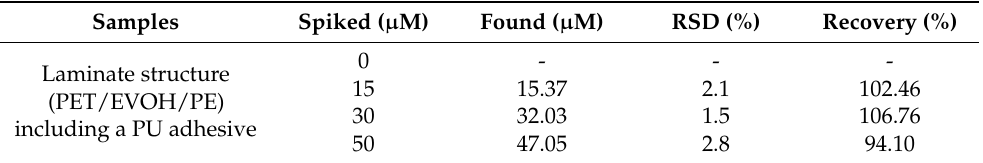
Table 2. Determination of MDA in the real sample using MIP/MWCNT-modified electrodes. Three replicates were made for each